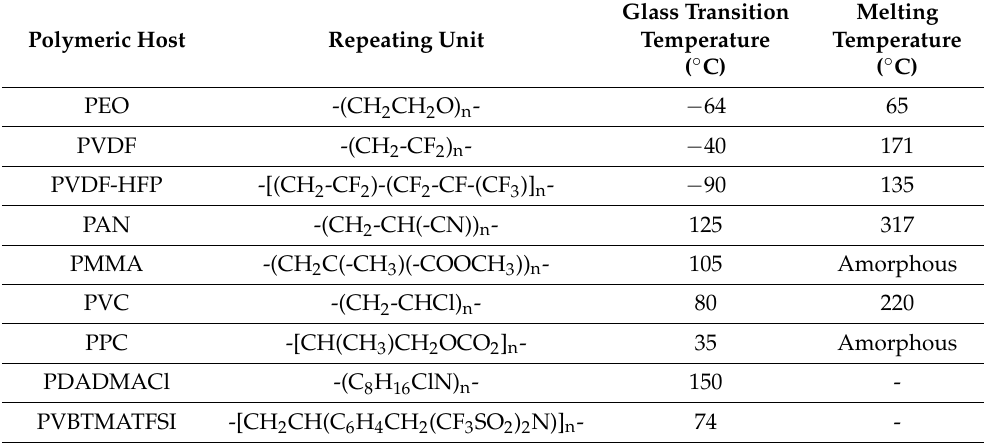
Table 3. Properties of polymeric host